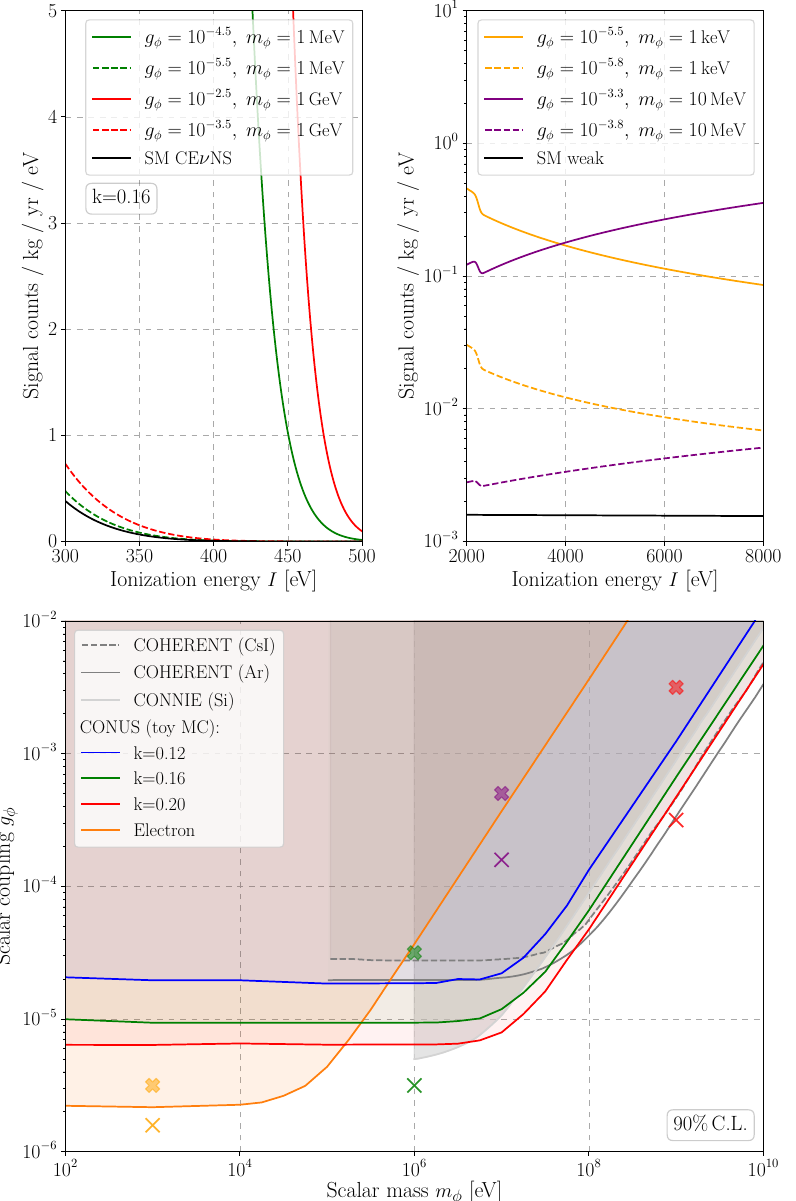
Figure 6 . Top: expected light scalar signals of detector C1 in the low energy region below 500 eV ee for a quenching parameter of k = 0 . 16 (left) and in the higher energy region between 2 and 8 keV ee (right) for different couplings and masses in comparison to the SM signals of CE ν NS and elastic neutrino-electron scattering, respectively. Note that the wiggles at ∼ 2 keV are not artifacts but result from the applied reactor model. Bottom: limits (90% C.L.) on the light scalar mediator parameters ( m φ , g φ ) deduced from CE ν NS and neutrino-electron scattering with the Run -1 Conus data sets. As before, we point out the exemplary parameter points of the signal spectra above. Bold crosses indicate parameter points that can already be excluded while regular crosses refer to points that are still in agreement with the data. For comparison, limits obtained from Coherent (CsI and Ar) data (90% C.L.) [161] and Connie (95% C.L.) [53] are